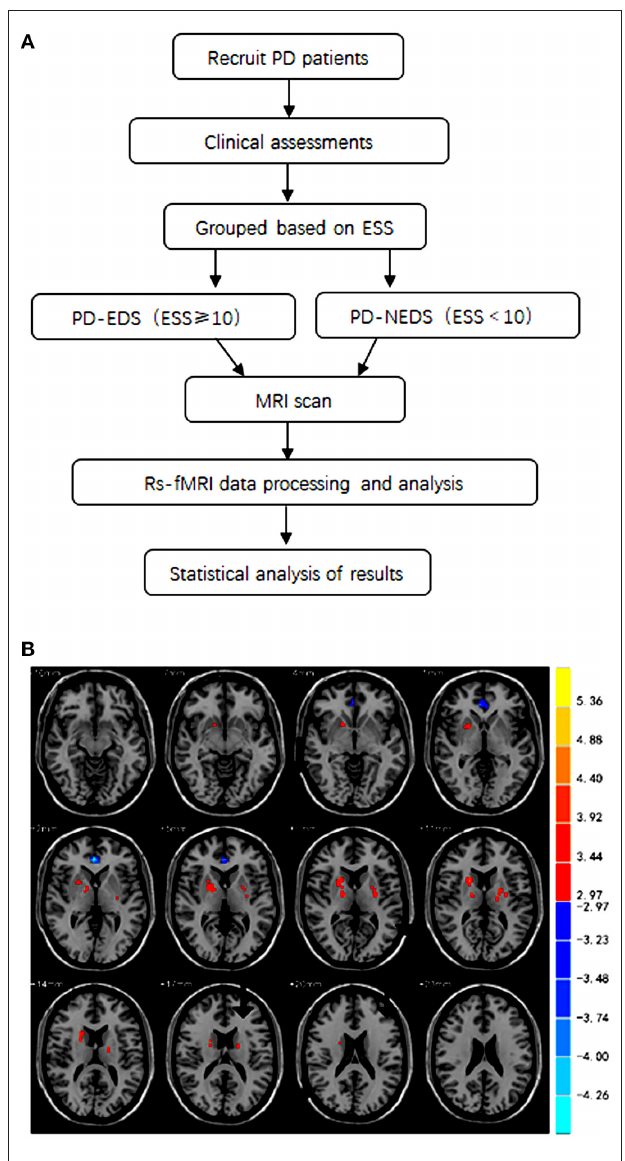
FIGURE 1 | (A) A flowchart of the collection of patients and study design. (B) The brain areas with statistically significant differences in fALFF values between the PD-EDS and PD-NEDS group ( P < 0.05, AlphaSim